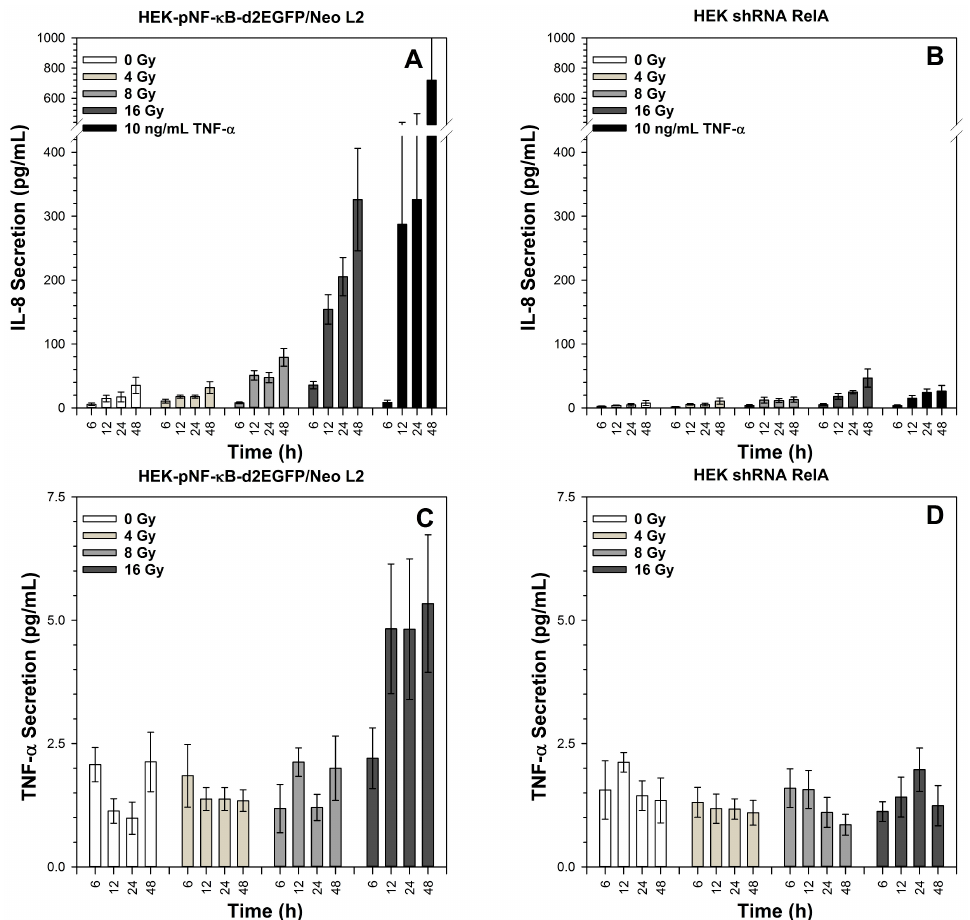
Figure 8. Kinetics of IL-8 and TNF- α secretion of HEK-pNF- κ B-d2EGFP/Neo L2 ( A , C ) and HEK shRNA RelA cells ( B , D ) after X-irradiation. The supernatants were collected at the indicated time points. The TNF- α and IL-8 content of the supernatants was determined by means of a multiplex ELISA. Mean and standard error of three independent experiments with duplicate cytokine determination are shown.